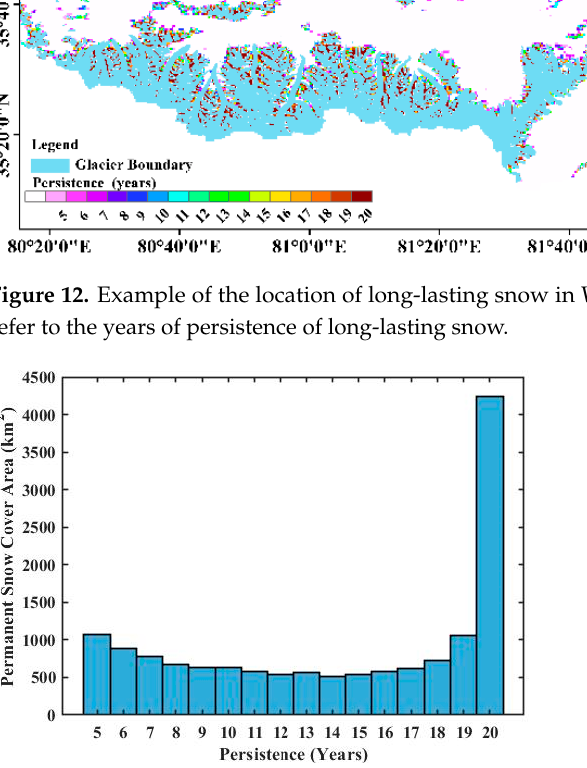
Figure 13. Frequency distribution of the long-lasting snow in Tarim Basin in 2000–2020.